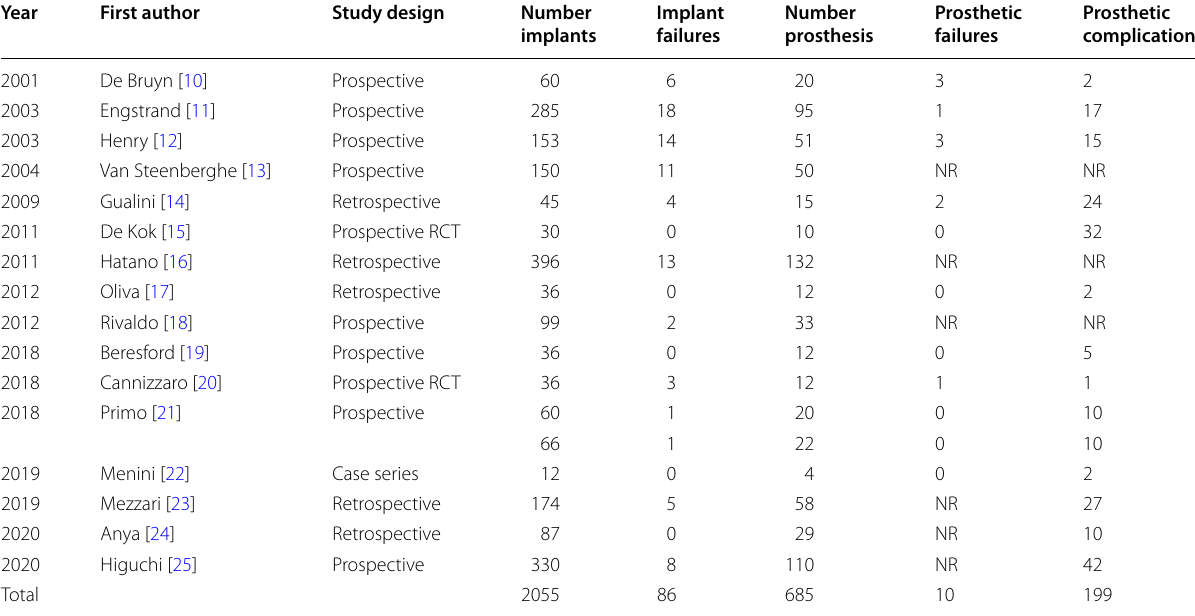
Table 2 Overview of the implant and prosthetic failures